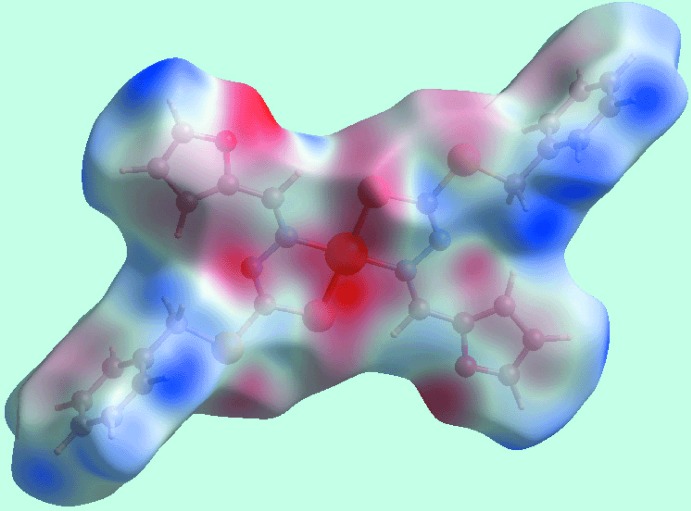
A view of the Hirshfeld surface for (I) mapped over the electrostatic potential in the range −0.036 to + 0.034 atomic units.